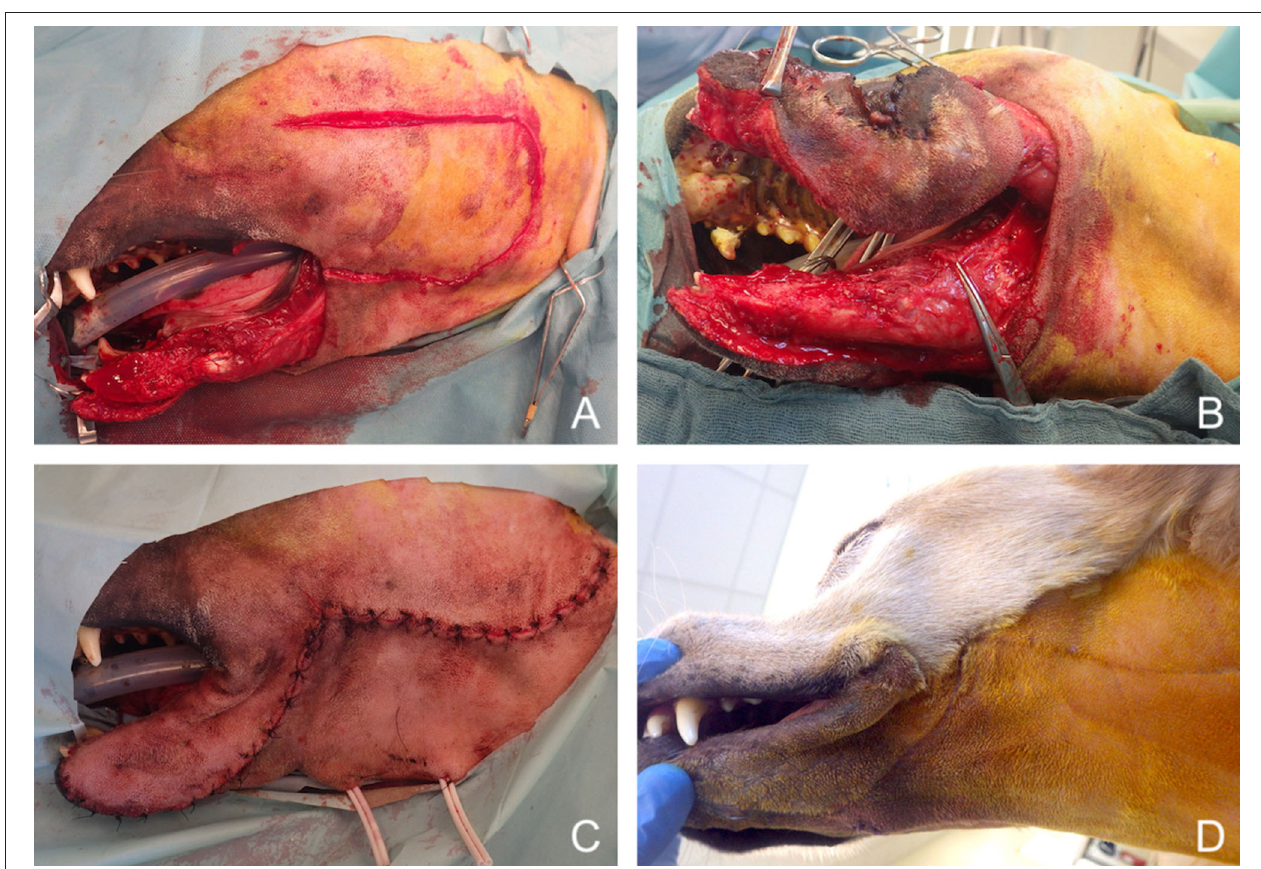
FIGURE 13 | Reconstruction of a composite defect of the lower face with a facial (angularis oris) myocutaneous flap. (A) Composite resection of the body of the mandible and lower lip in a dog presenting with a neurofibrosarcoma. (B) Surgical preparation of the flap. (C) Immediate postoperative appearance. (D) 9-months postoperative